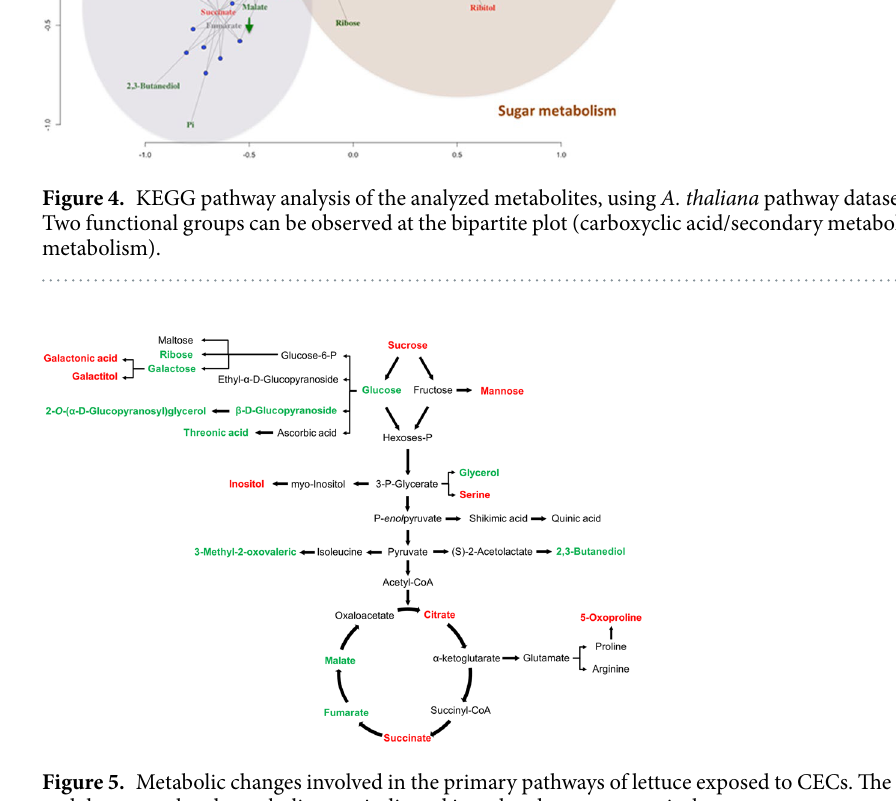
Figure 5. Metabolic changes involved in the primary pathways of lettuce exposed to CECs. The significant up and down regulated metabolites are indicated in red and green